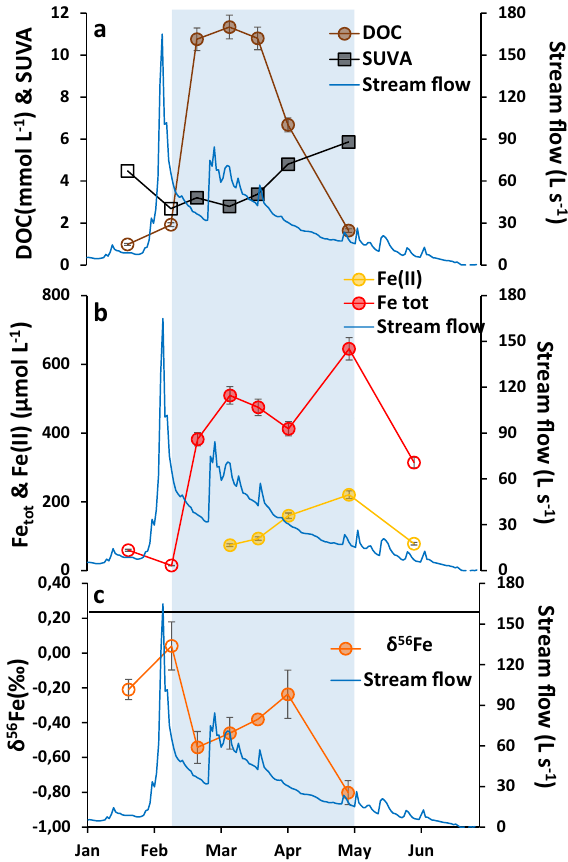
Figure 2. Evolution of DOC and SUVA ( a ), Fe(II) and Fe tot ( b ), and δ 56 Fe ( c ) in 2017 versus date during the seasonal anoxic/oxic periods. The stream discharge is illustrated in blue. The straight line ( c ) demonstrates the Fe isotope composition of the wetland soil at 0.26 ± 0.07‰ in the sampled soil solution horizon (the chemical composition of the soil was determined by SARM, Supplementary Table S5). The blue zone illustrates the anoxic periods. The filled and empty symbols correspond to samples under anoxic and oxic conditions, respectively. Analytical error bars were calculated by (i) measuring the standard for DOC, Fe(II) Fe tot , and δ 56 Fe (2SD) analyses, and (ii) Eq. (3) if there were replicates of